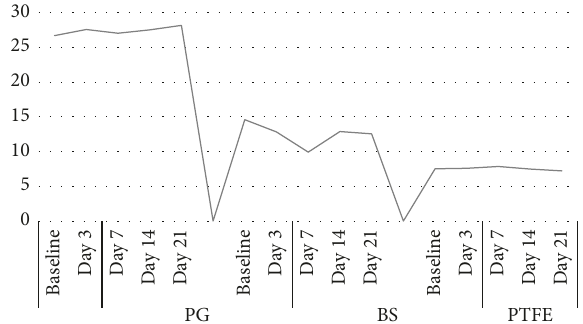
Figure 2: Tensile strength of various absorbable and nonabsorb- able sutures according to immersion time in synthetic saliva. The tensile strength values are means expressed in Newtons. PG: polyglactin, BS: black silk, PTFE: polytetrafluoroethylene